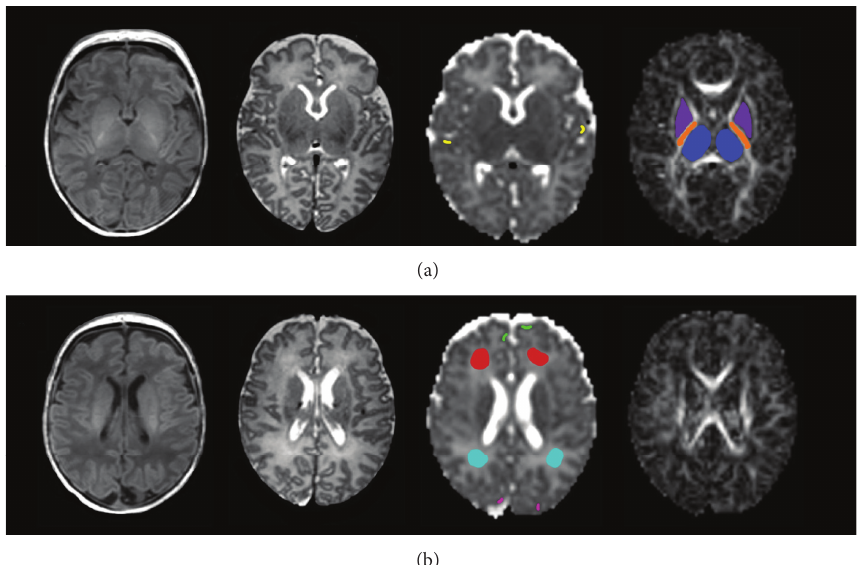
Figure 1: Regions of interest. Axial T1-weighted images, T2-weighted images, apparent diffusion coefficient (ADC) maps, and fractional anisotropy (FA) maps at two different levels of cerebrum showing the manually drawn regions of interest: (a) lower level and (b) higher level. ADC and FA values were measured in eight different regions of interest in the cerebrum: that is, in the thalamus, the posterior limb of the internal capsule and the lentiform nucleus, the white matter (within the frontal and posterior white matter), and the cortical grey matter (within the frontal, parietal, and occipital cortices). Regions of interest were always drawn by the same observer by looking at the same time at the ADC and FA maps and the corresponding T1- and T2-weighted imaging.